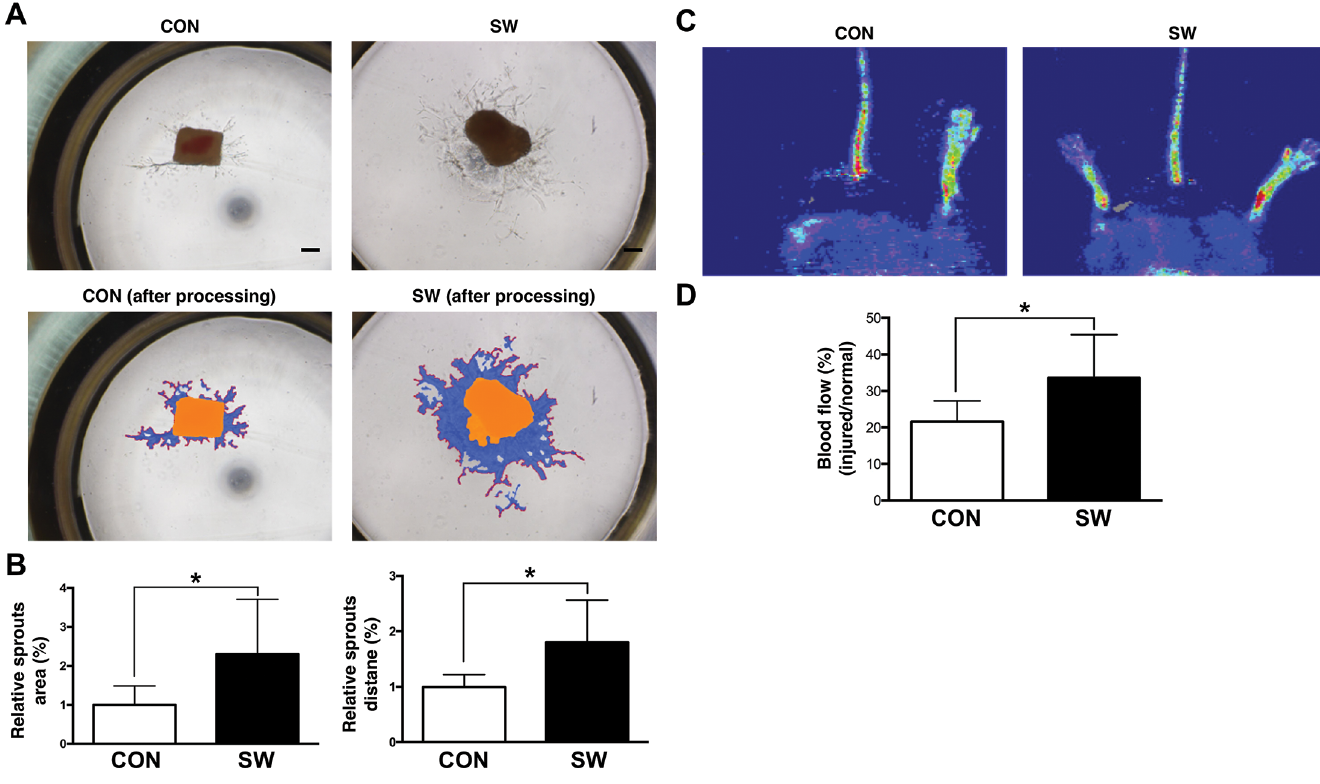
Figure 4. Shock wave (SW)-induced angiogenesis ex vivo and in vivo . (A) Representative sprouting morphology in ob/ob mice carotid artery with (n = 8) and without (n = 9) SW treatment (scale bar, 200 μ m). Upper panel: Original images; Lower panel: Computer-pro- cessed images by WimSprout image analysis for sprouting determination. (B) Parameters of sprouting assay, including sprout area and sprout distance. (C) Representative images of laser Doppler flowmetry in ob/ob mice without (CON) and with SW treatment 14 d post-critical limb ischemia (CLI). (D) Measurement of blood flow post-CLI without (CON, n = 9) and with (n = 7) SW treatment by laser Doppler flowmetry. Data presented as mean ± S.D. * P < 0.05 determined by Student t